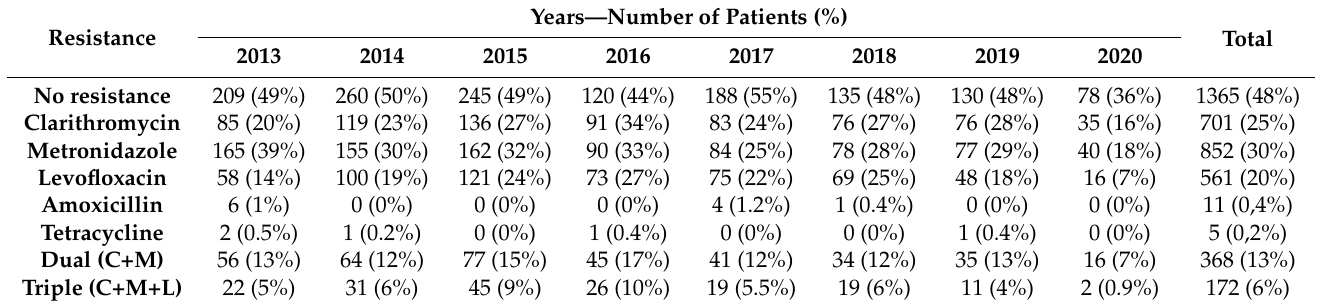
Table 1. Helicobacter pylori antimicrobial resistance trends between 2013 and 2020 in naïve patients. Years—Number of Patients (%) Resistance